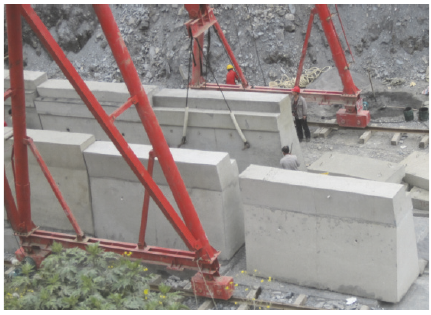
Figure 1: Assembly scene of assembled